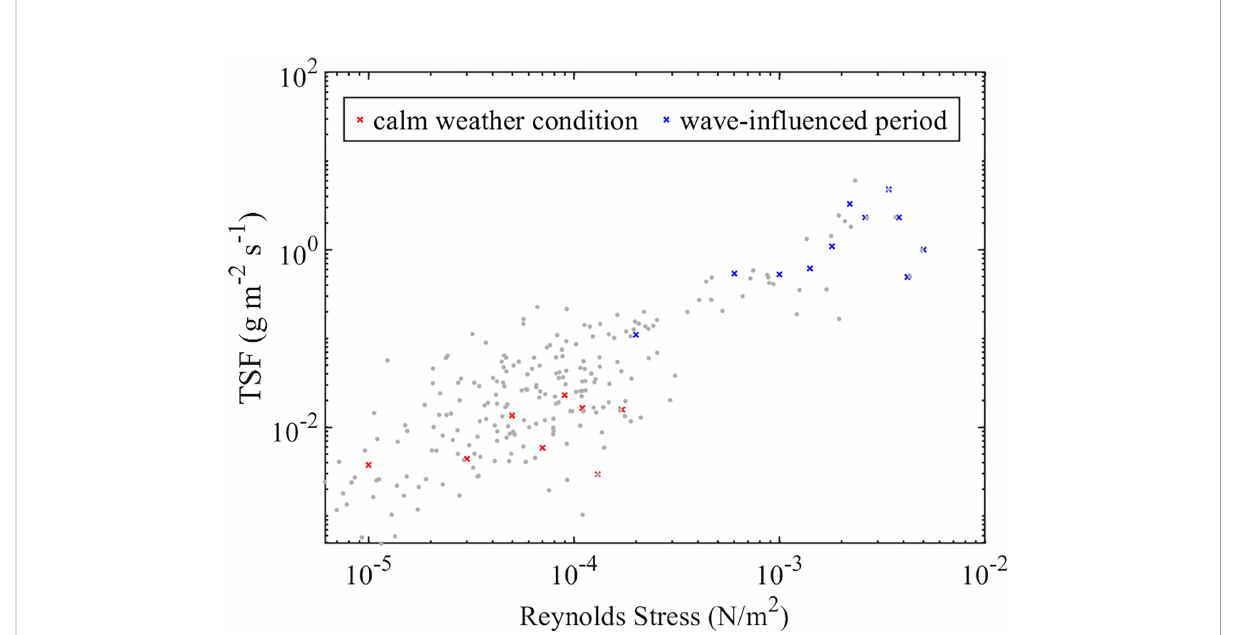
FIGURE 13 Scatter plot of turbulent Reynolds stress and turbulence-induced sediment vertical diffusion fl ux (TSF). Gray dots indicate burst-averaged values, while red and blue symbols represent calm weather conditions and wave-in fl uenced episodes, respectively. The abscissa values of the red and blue points should be uniformly distributed; discontinuity indicates no sample points in the corresponding value